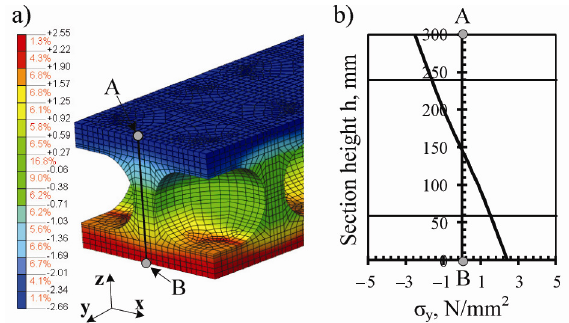
Fig. 11. Stress distribution in the concrete of the slab cross- section, point 1: a) overall image; b) graphic image